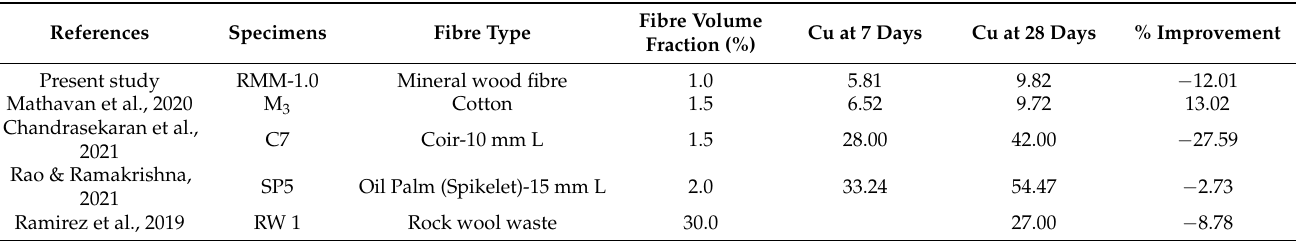
Table 5. Comparison of present with previous studies in terms of optimal compressive strength values and improvement attained [22,32–34].